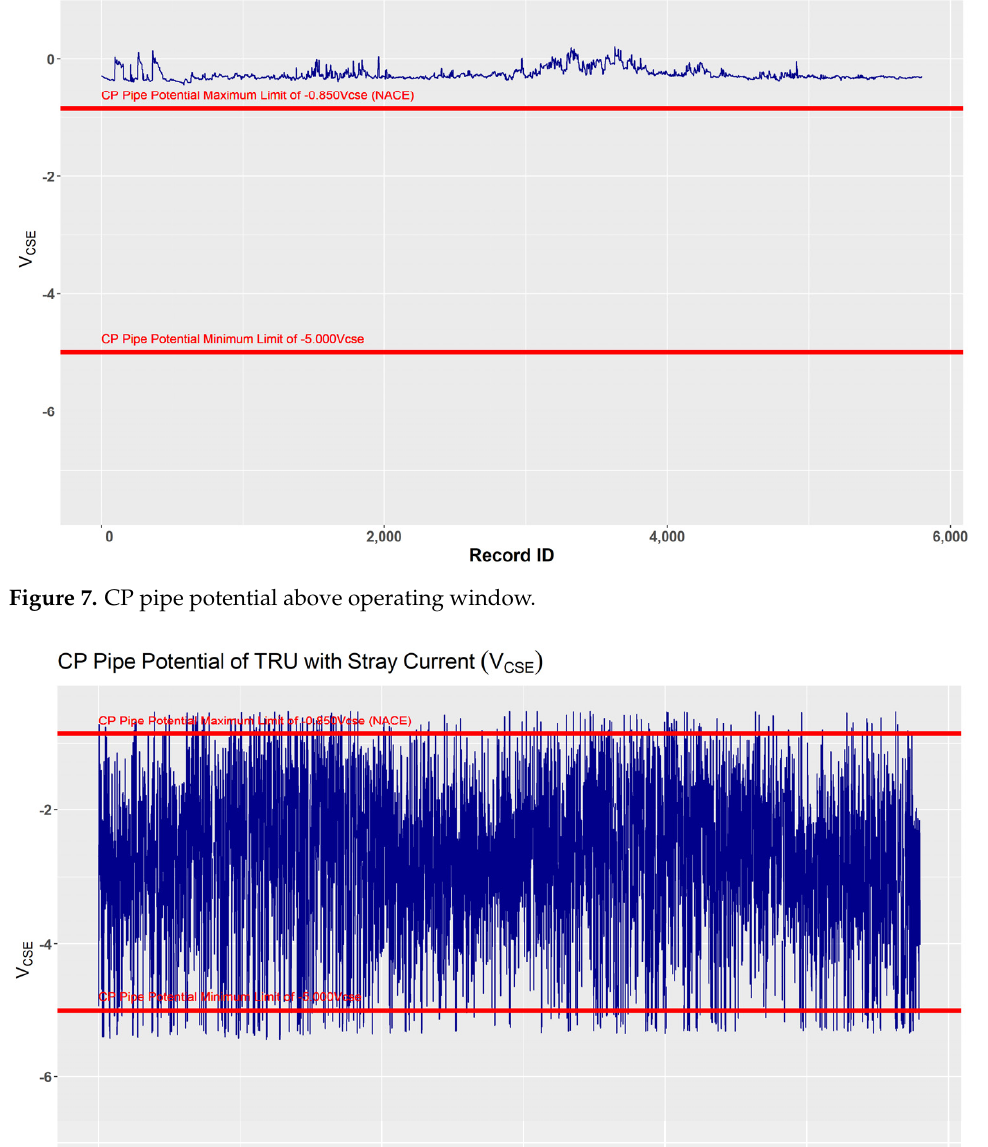
11 of 26 Figure 6. CP pipe potential below operating window.